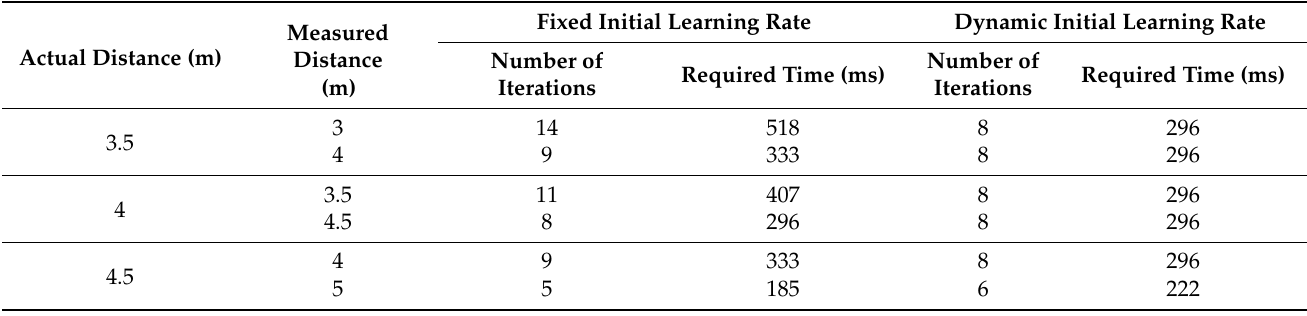
Table 5. Number of iterations and required time at different